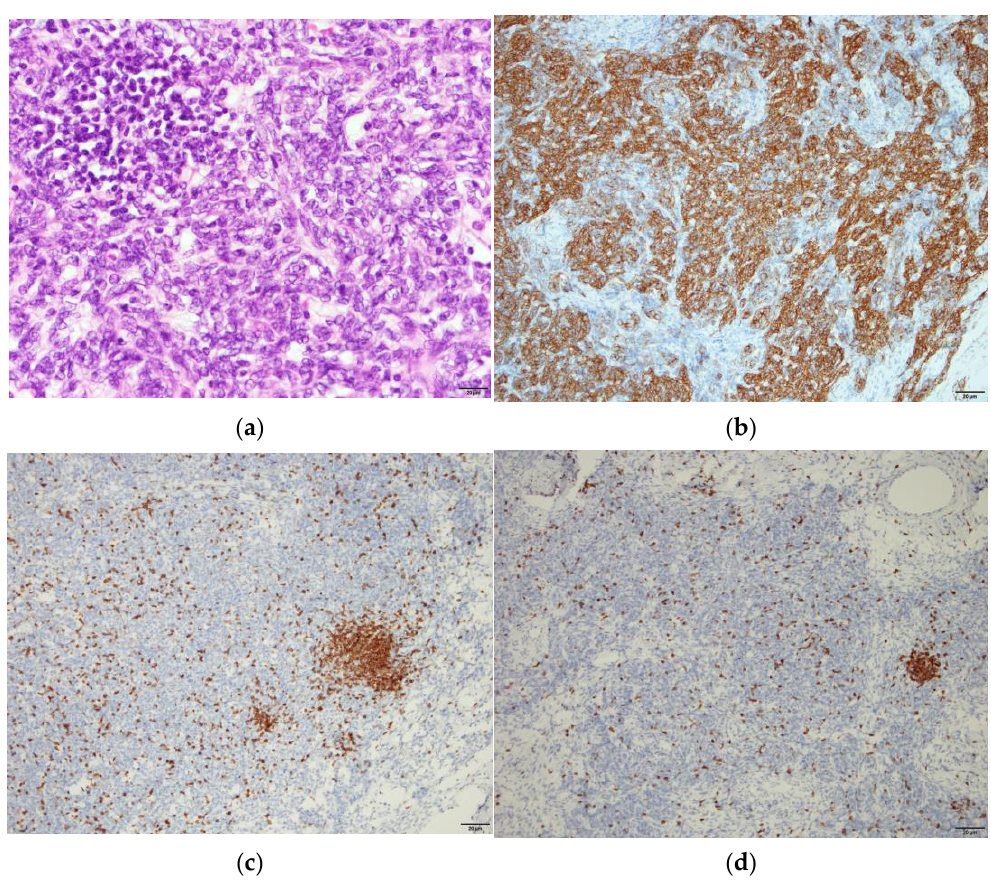
Figure 5. Microscopic appearance of the lesion. ( a ) Spindle epithelium mixed with small lymphocytes of the thymic tissue. ( b ) Immunohistochemistry (IHC) stains of cytokeratin revealed positive over epithelium component ( c ) IHC stains of CD 45 revealed positive for lymphocytes ( d ) IHC stains of CD5 revealed negative over epithelium